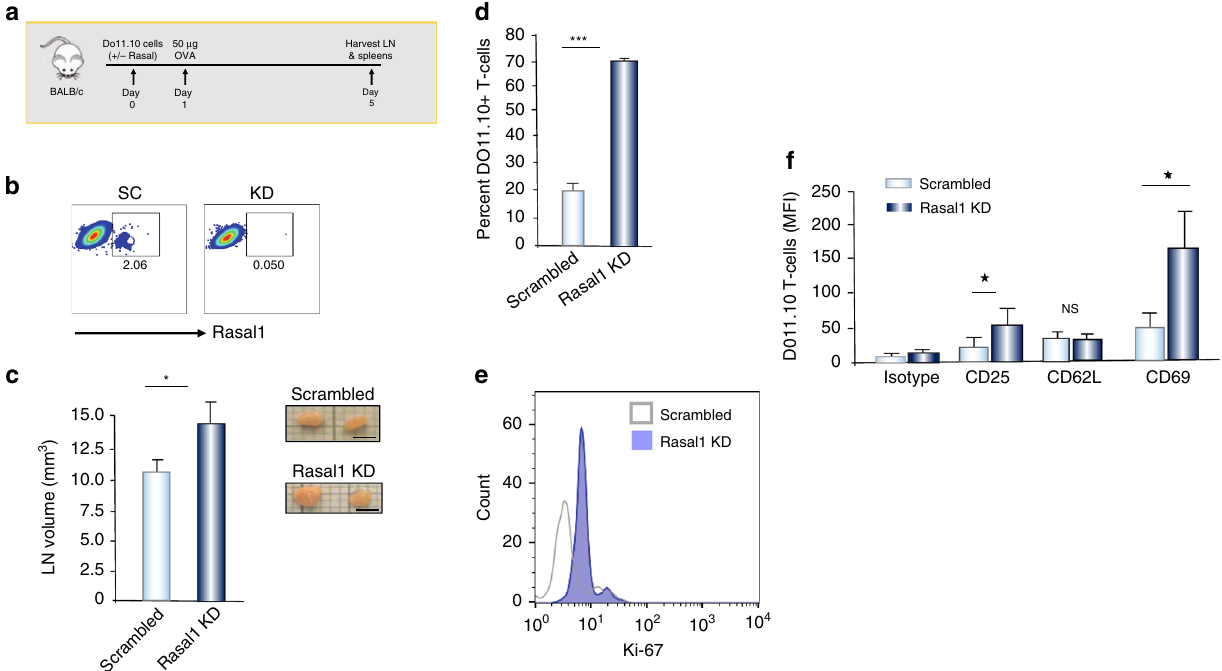
Fig. 6 Rasal1 inhibits in vivo T-cell activation by peptide antigen. a Upper: schematic of DO11.10 T-cell injection followed by OVA peptide injection and an assessment of LNs at day 5. b FACS pro fi le of Rasal1 expression in T cells transfected with scrambled siRNA (left) and Rasal1 siRNA (right). c Rasal1 siRNA KD increases the size of lymph nodes, right inset: examples of LNs (scale bar, 2.5 mm). d Rasal1 KD increases the percent of DO11.10 T cells in lymph nodes; e Rasal1 KD increases the presence of DO11.10 T cell with the expression of proliferation marker Ki67; f Mean fl uorescence intensity levels (MFIs) of various receptors. T cells were analyzed by fl ow cytometry for the expression of CD25, CD62L, and CD69 ( n >